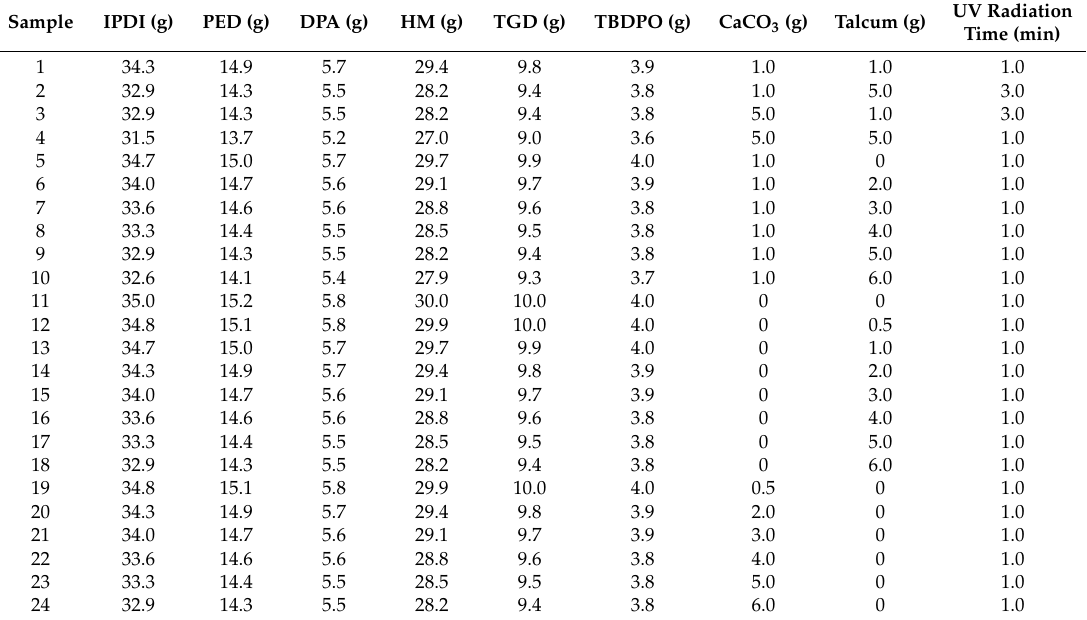
Table 1. Composition of waterborne UV-curing coatings on the wood materials (WUVCW).